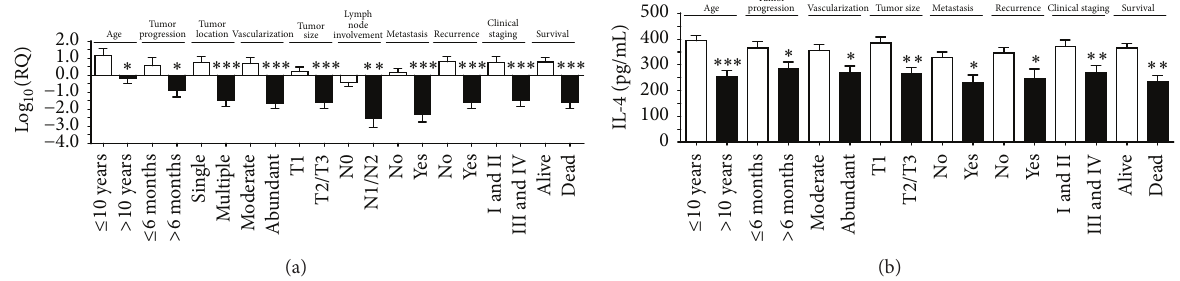
Figure 2: IL-4 gene overexpression correlated with (a) age ≤ 10 years; tumor progression for less than 6 months; single tumor location; moderate tumor vascularization; tumor mass size less than 3 cm; no lymph node involvement; no metastasis; no recurrence; clinical staging I or II; and animals that were alive at the end of the followup period. Higher IL-4 protein levels correlated with (b) with age ≤ 10 years; tumor progression for less than 6 months; moderate tumor vascularization; tumor mass size less than 3 cm; no metastasis; no recurrence; clinical staging I or II; and animals that were alive at the end of the followup period. Error bars ± standard error; ∗ 𝑝 < 0.05 ; ∗∗ 𝑝 < 0.01 ; ∗∗∗ 𝑝 < 0.001 indicate significant differences according to Student’s 𝑡 -test.